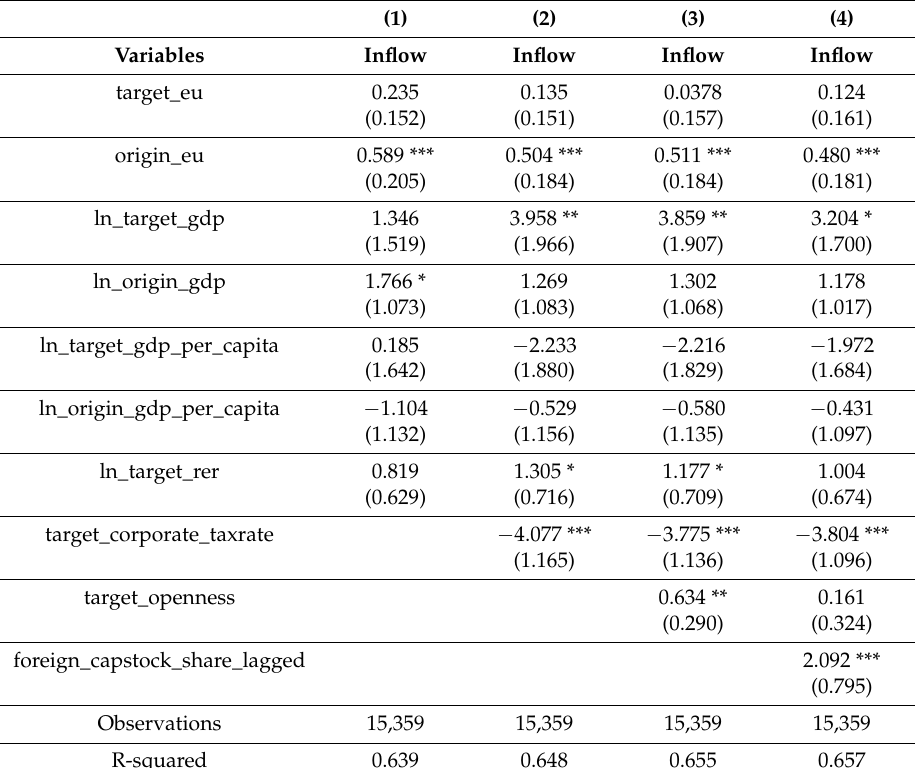
Table 3. Results for dyadic fixed panel data estimation using PPML estimators for FDI